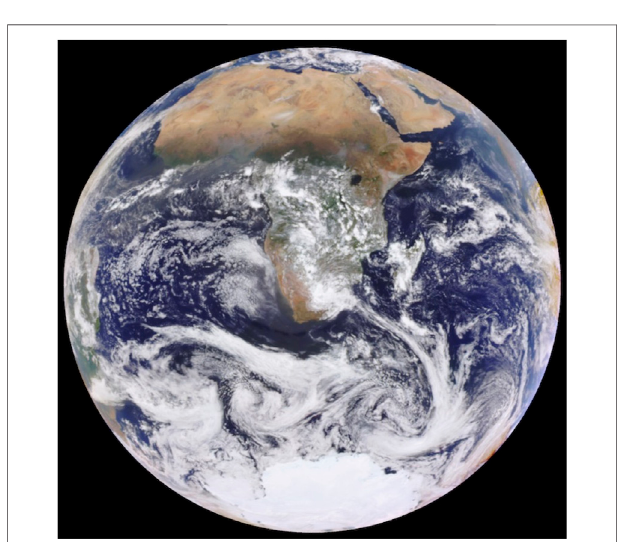
FIGURE 5 | The RGB image from EPIC observation taken at 11:15 UTC on January 4, 2017.